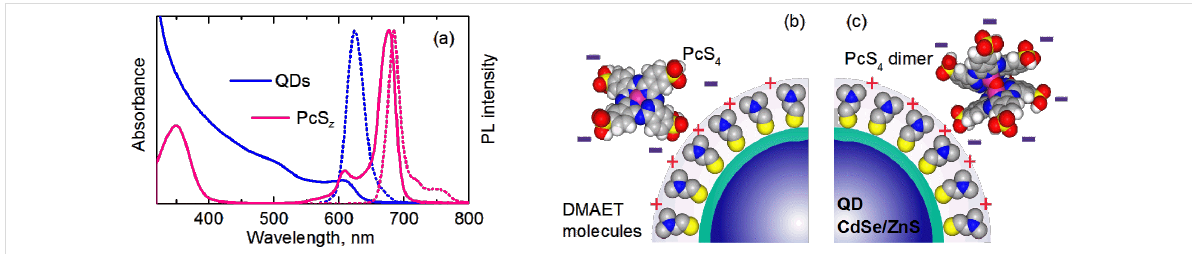
Figure 1: (a) UV–vis absorption (solid lines) and normalized PL spectra (dotted lines) of DMAET capped CdSe/ZnS quantum dots and PcS z in aqueous solution. Schemes of linkage of DMAET-capped CdSe/ZnS QD and sulfonated Al(OH)phthalocyanine complexes in aqueous solution by the example of PcS 4 : (b) QD–PcS 4 monomer complex, (c) QD–PcS 4 dimer